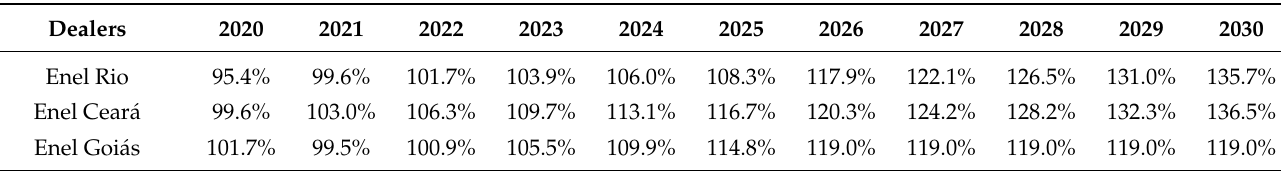
Table A2. The growth rate of the distributor’s MMDG market.